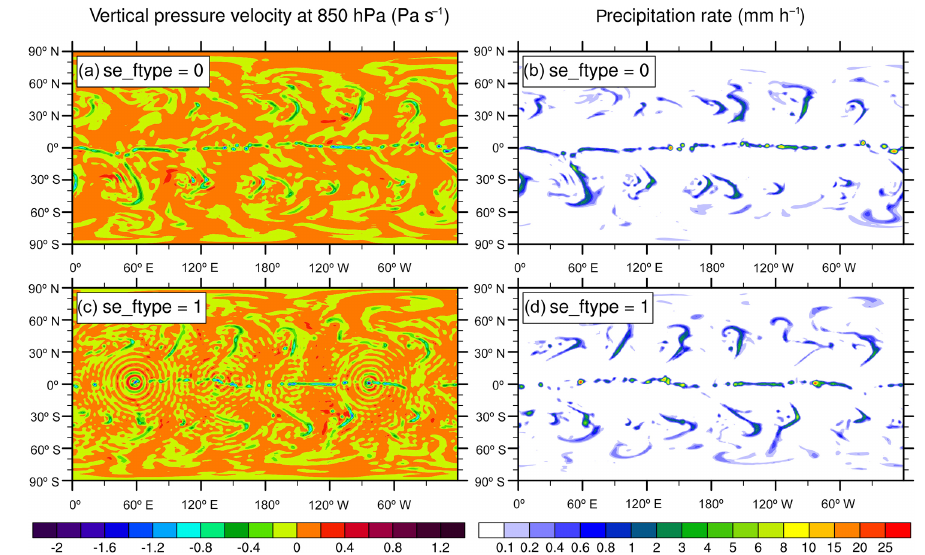
Figure 9. Instantaneous latitude–longitude snapshots of the (left) 850hPa vertical pressure velocity and (right) large-scale precipitation rate for two different physics–dynamics coupling strategies in CAM5-SE with moist idealized physics (MITC). (a, b) gradual application of the physics tendencies in the sub-cycled dynamical core (se_ftype = 0) and (c, d) sudden adjustment of the prognostic variables at each physics time step (se_ftype =